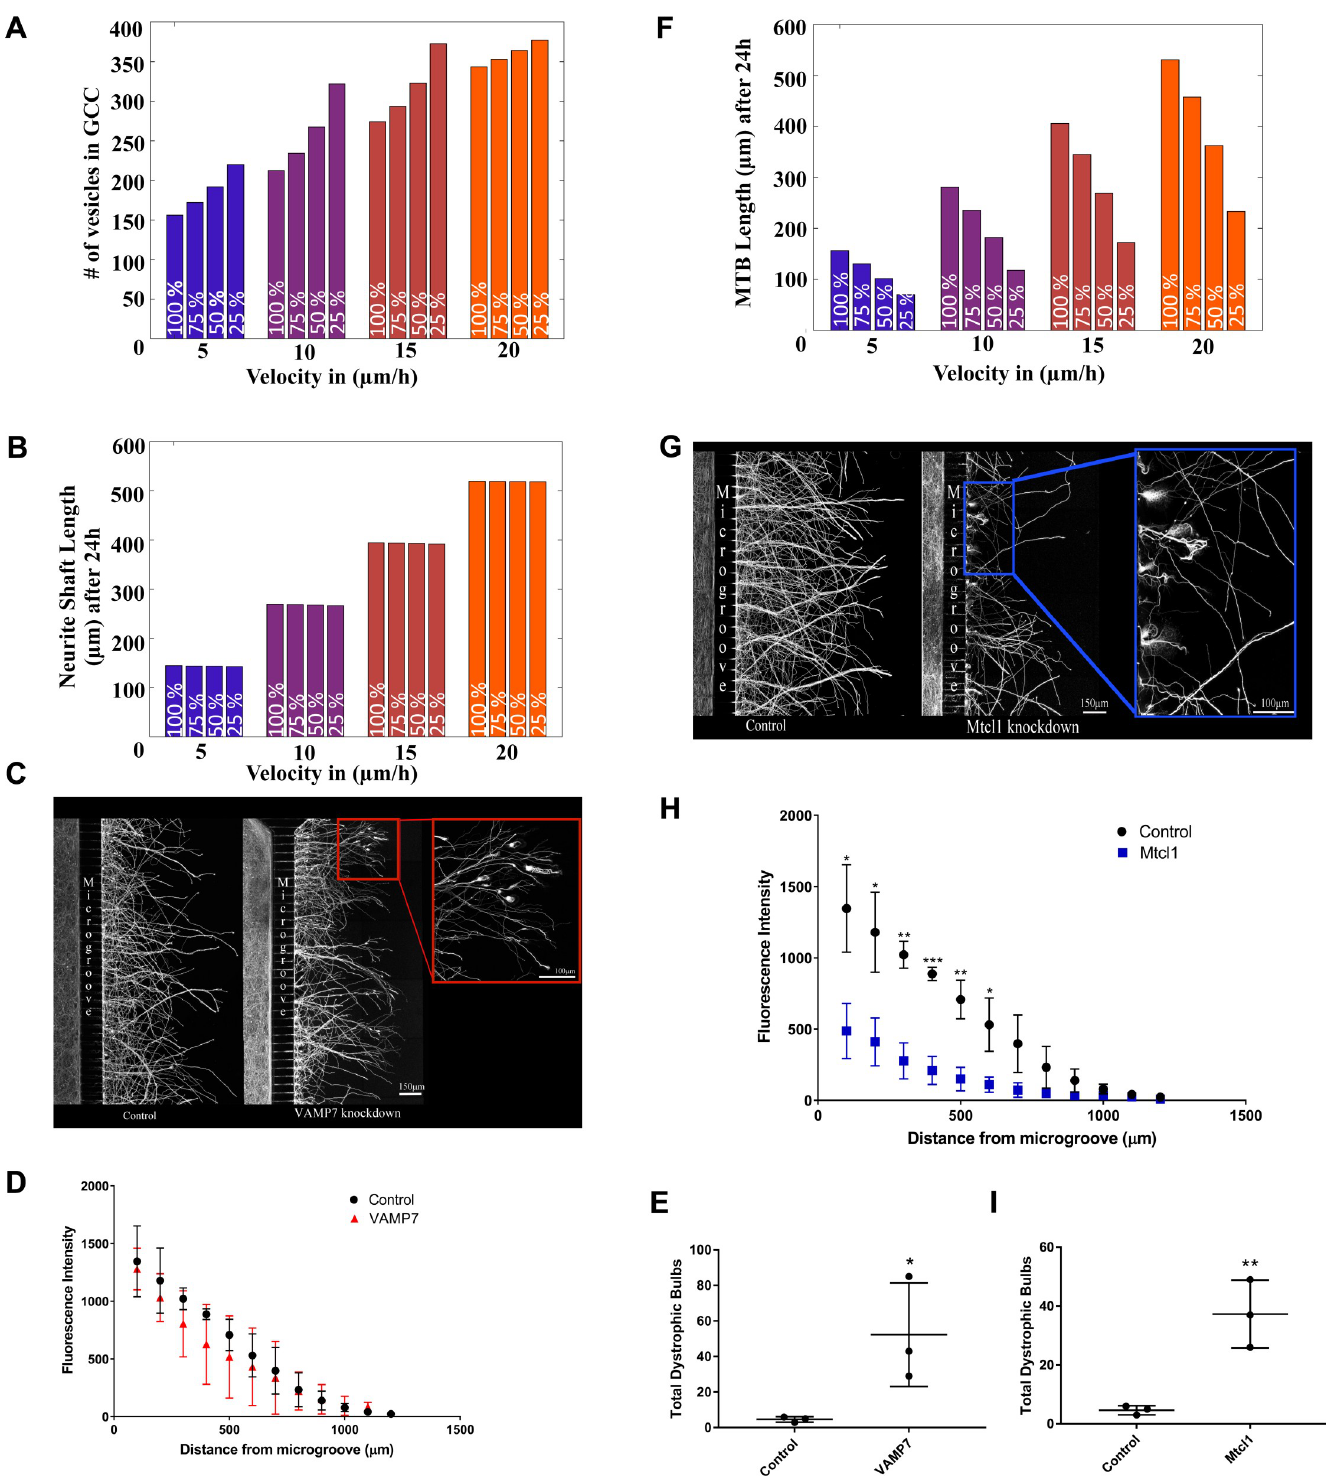
Fig 9. Imbalanced SCP dynamics disturb neurite outgrowth. (A-B) We predicted four sets of kinetic parameters that allow coordinated NOG at the velocities 5, 10, 15 and 20 μ m/h. To simulate the effect of uncoordinated vesicle SCP dynamics we decreased the count and production rate of v-SNARE V to 25%, 50% and 75% of the original prediction, without modifying any other parameters. Numerical simulations predict that reduced exocytosis causes an increase in the count of vesicles in the growth cone cytoplasm (A) without reducing NOG velocity (B). (C) We validated our prediction by analyzing neurite outgrowth after knockdown of the v-SNARE